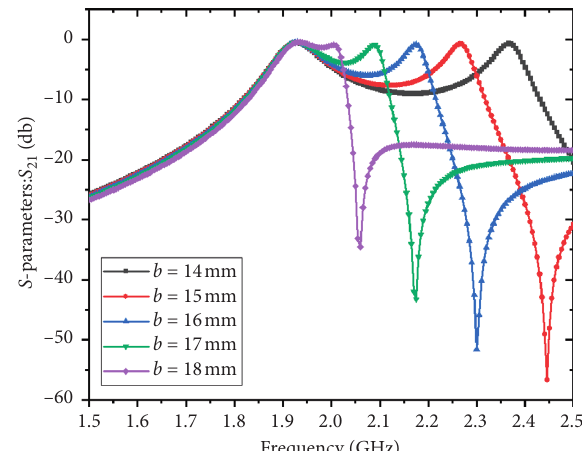
Figure 5: Simulated response of transmission zero located at the upper side of the operating frequency with different lengths of loaded open